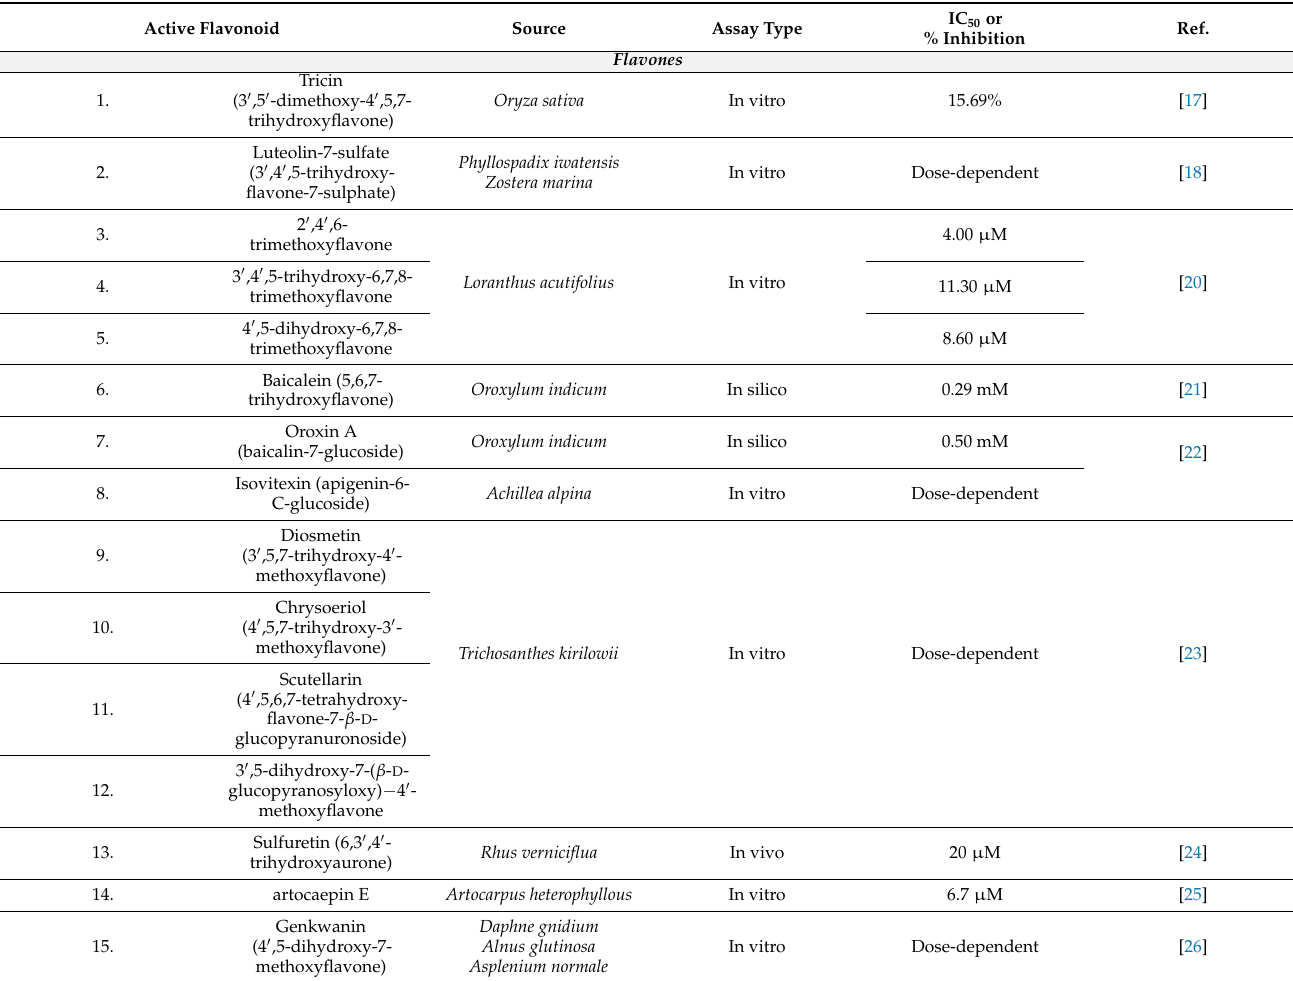
Table 1. List of promising antityrosinase flavonoids, their source, the type of the performed assays and their significance. Active Flavonoid Source Assay Type IC 50 or % Inhibition